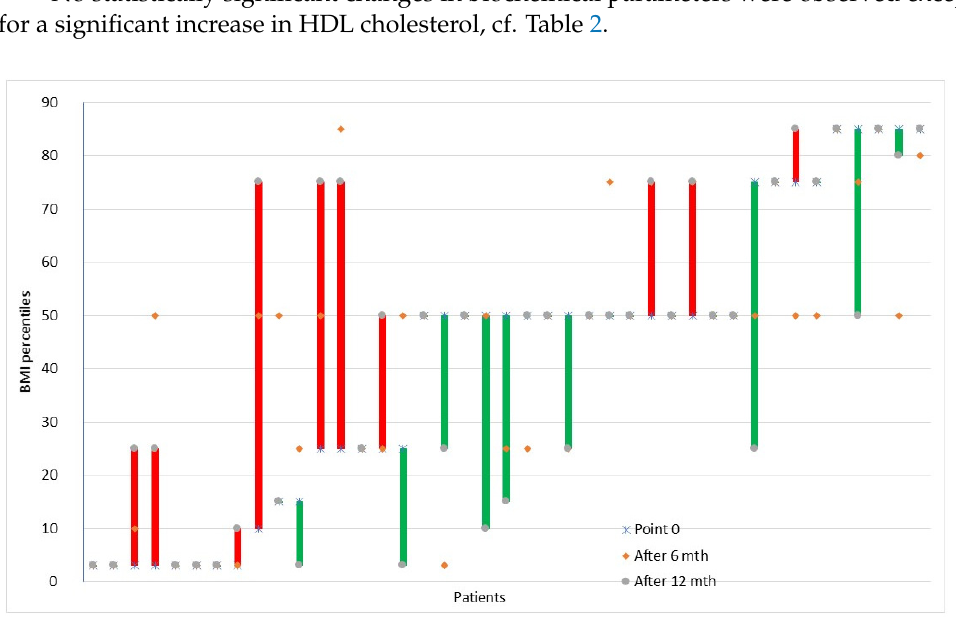
Figure 2. Changes in individual children’s BMI percentiles in time. The lines describe the BMI percentile change individually for each child between three time points: before diagnosis (point 0) and after 6 and 12 months. Red means increase and green means decrease.